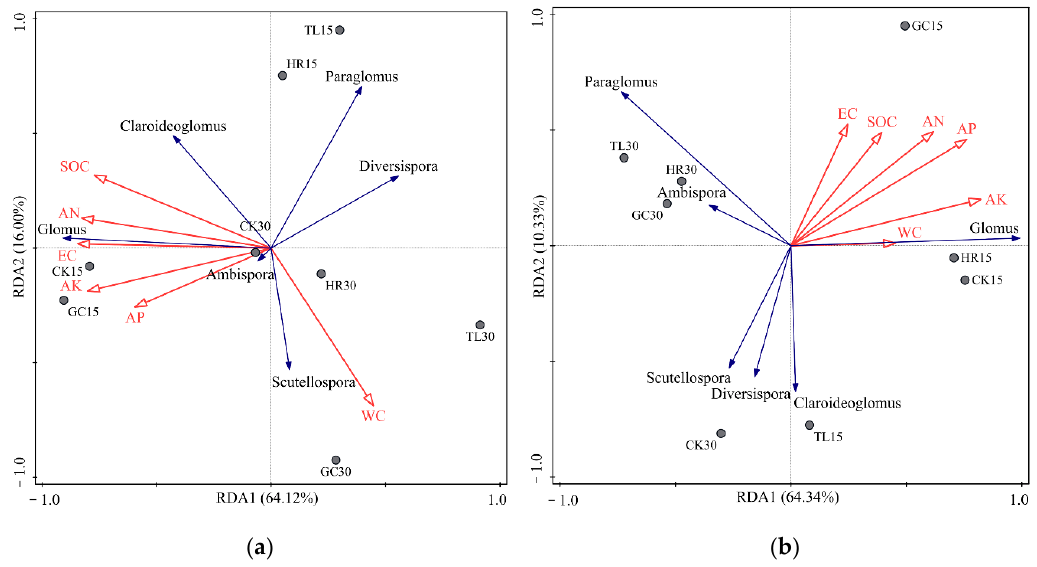
Figure 7. Redundancy analysis (RDA) showing the relationships between soil physicochemical properties and the AMF community in spring ( a ) and winter ( b ). The RDA model for spring and winter was significant ( p < 0.05). The first axis (RDA1) of the RDA plot was significant in both spring ( p = 0.032) and winter ( p = 0.045).